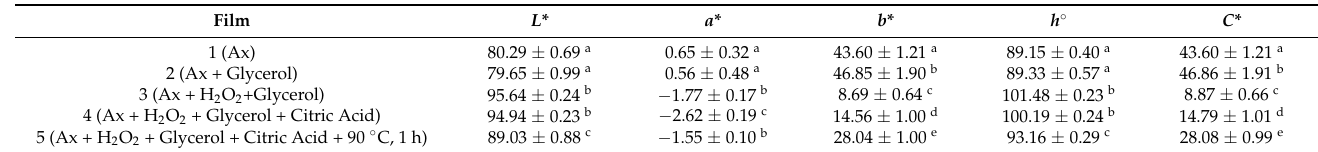
Table 2. Values of lightness ( L *), chromaticity coordinates ( a *, b *), and the calculated hue ( h ◦ ) and chroma ( C *) for the arabinoxylan films obtained. Values in the same column followed by different superscript letters differ significantly ( p < 0.05).